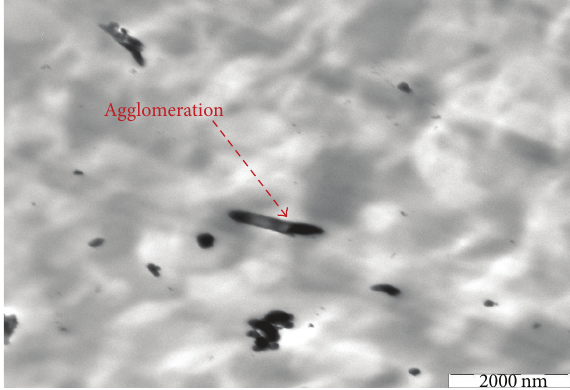
Figure 16: TEM observation of cryothin sectioning for PP/5% nano 𝛼 -Al 2 O 3 composites in the presence of